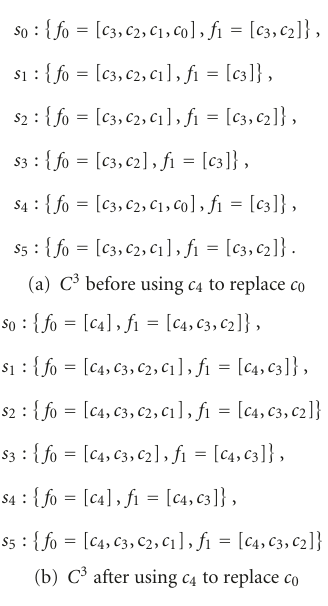
Figure 3: Data cached in 6 wireless nodes ( s 0 through s 5 ) each with two bu ff er units. We omit the coe ffi cients for each combined data segment for ease of exposition; however, it should be known that f 0 ∈ s 0 is not the same as f 0 ∈ s 4 as they are coded with di ff erent coe ffi cient vectors. (a) shows C 3 before insertion of c 4 , and (b) shows C 3 after the insertion of c 4 and removal of c 0 . After this data replacement operation, the system is fairly stable in terms of the cardinalities of the combined data